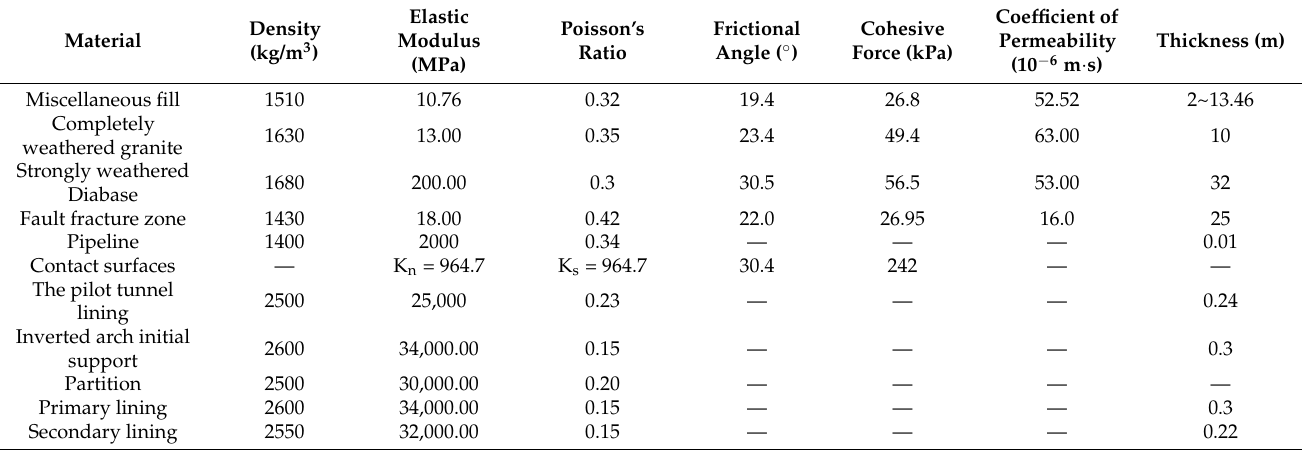
Table 1. Model material